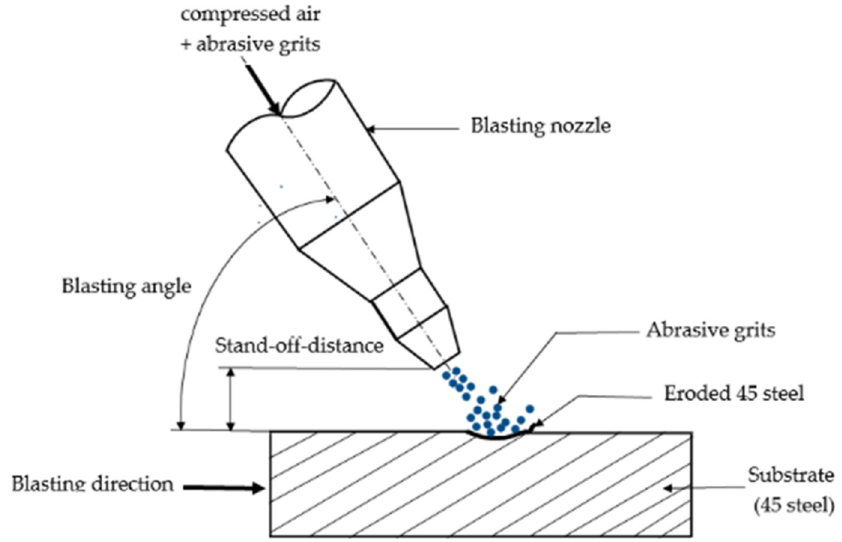
Figure 2. Schematic diagram of the grit blasting process. Table 1. Pre-treatment process of the substrate surface.